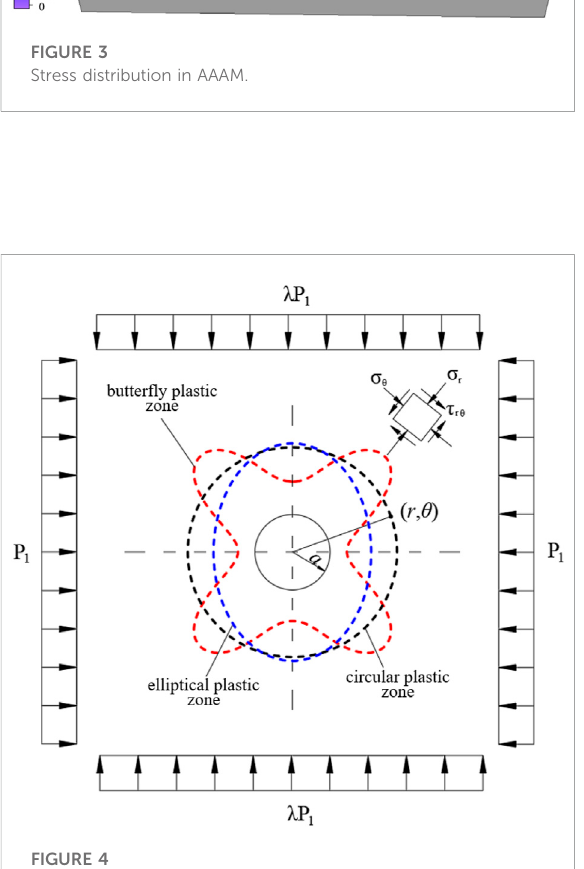
FIGURE 4 Stress model of roadway in a non-uniform stress fi